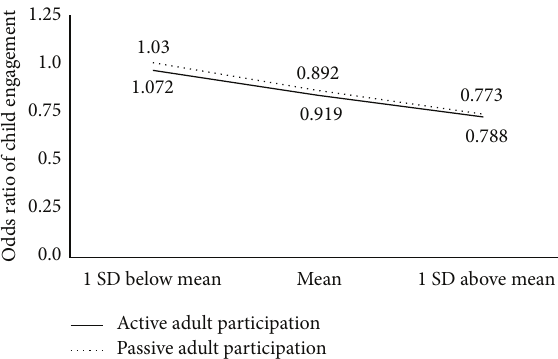
Figure 2: Interaction of active/passive adult participation and child language ability on child engagement. Figure 3: Interaction of active/passive adult participation and Child Behavior on child